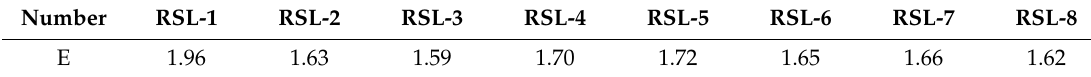
Figure 12. Calculation diagram of energy dissipation coefficient. Table 6. Energy dissipation coefficient.